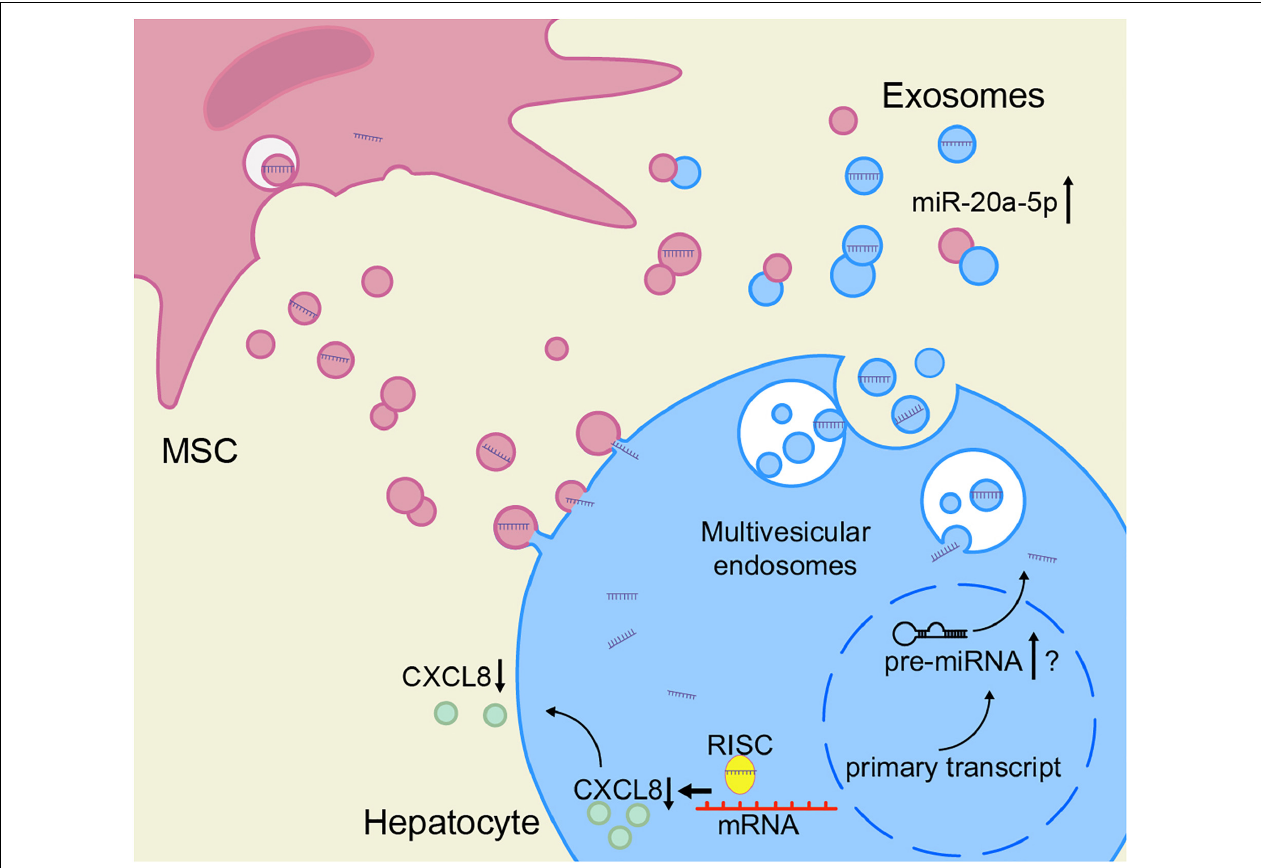
FIGURE 7 | hBMSCs inhibit liver inflammation via the miR-20a-5p/CXCL8 axis. The intracellular levels of miR-20a-5p in hepatocytes increase after the uptake of miR-20a-5p-rich exosomes. In turn, miR-20a-5p inhibits the expression of CXCL8 (together with RISC), resulting in reduced CXCL8 secretion. hBMSCs not only secrete miR-20a-5p-rich exosomes directly into the hepatic microenvironment but also may promote the endogenous synthesis of miR-20a-5p in hepatocytes and its secretion as exosomes via other pathways. The accurate detection of miR-20a-5p and its precursors is required to prove the latter hypothesis. RISC, RNA-induced silencing